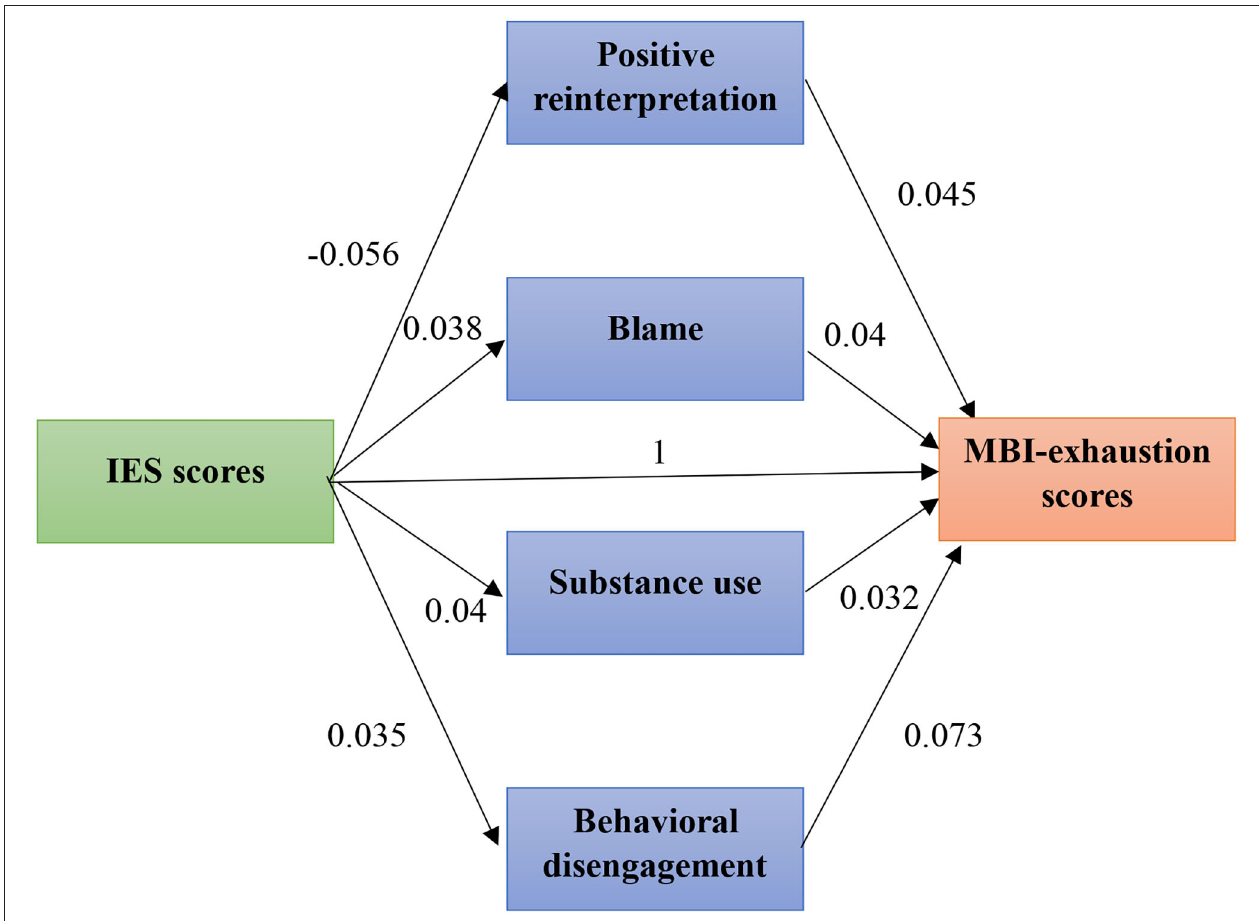
FIGURE 3 | Direct and indirect effect of stress on